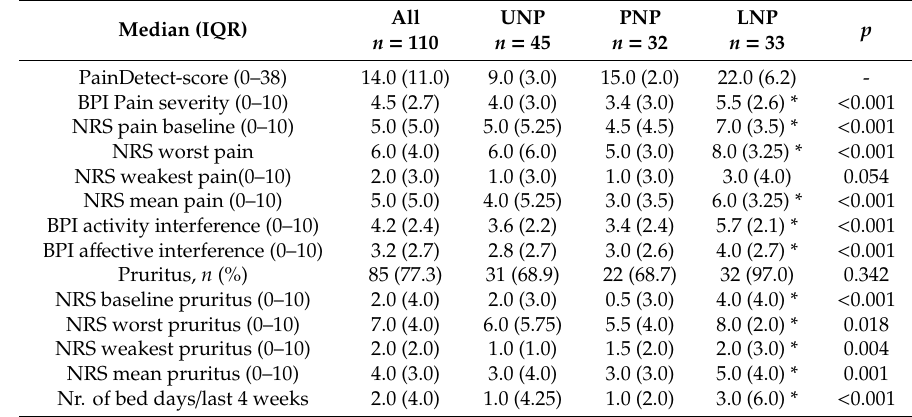
Table 3. Patient-reported outcome measures for pain and pruritus according to the PainDetect classification status: Unlikely Neuropathic Pain (UNP); Possible Neuropathic pain (PNP); Likely Neuropathic Pain